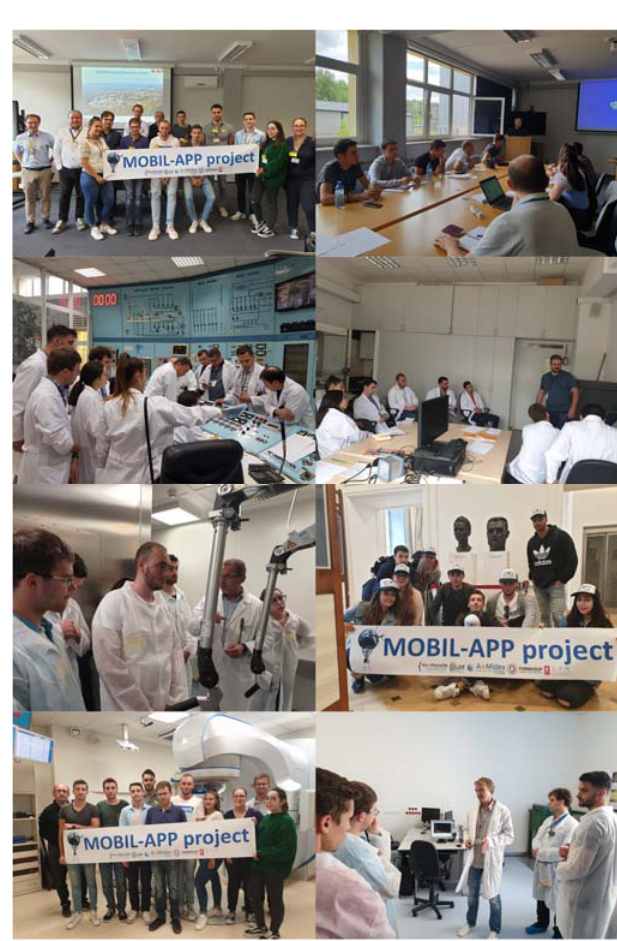
Fig. 7. Photographs associated to the mobility period in